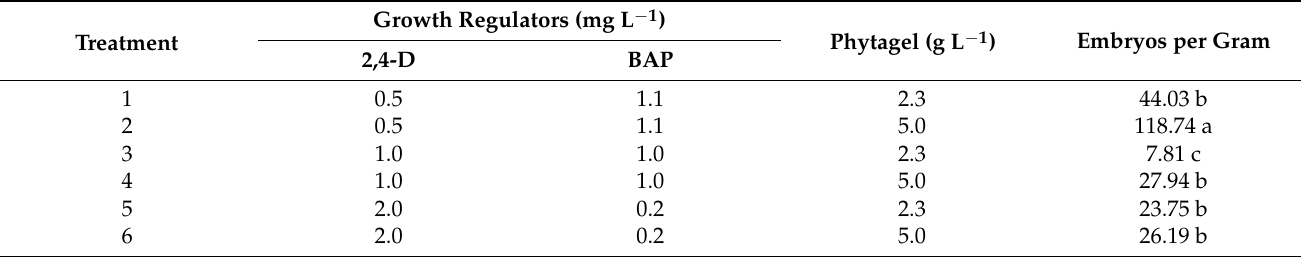
Table 3. Number of embryos formed from calli of C. arabica var. Colombia obtained in 6 different induction media, after 17 weeks cultured in a differentiation medium.